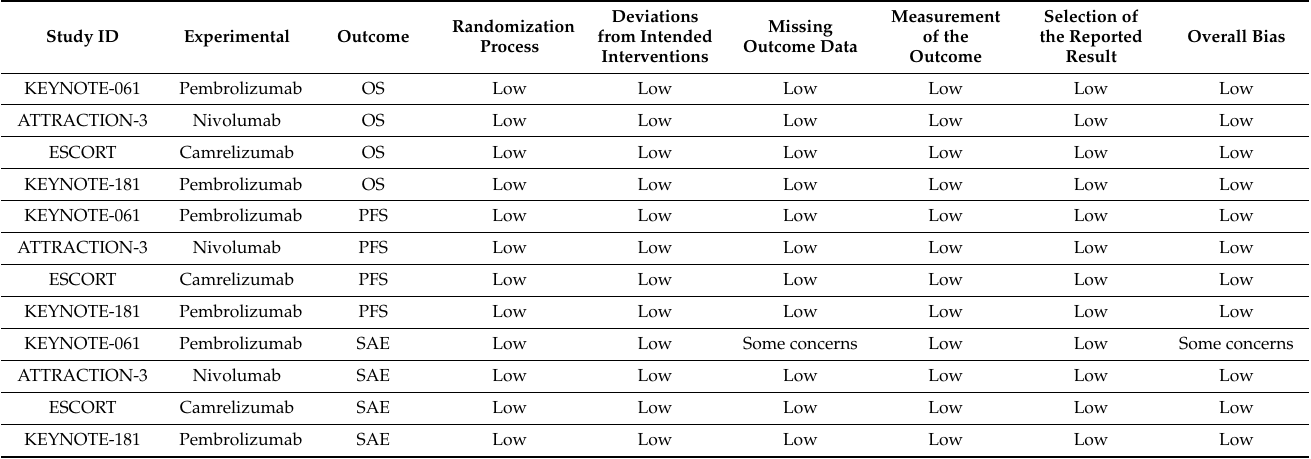
Table 4. Risk of bias assessment, second-line